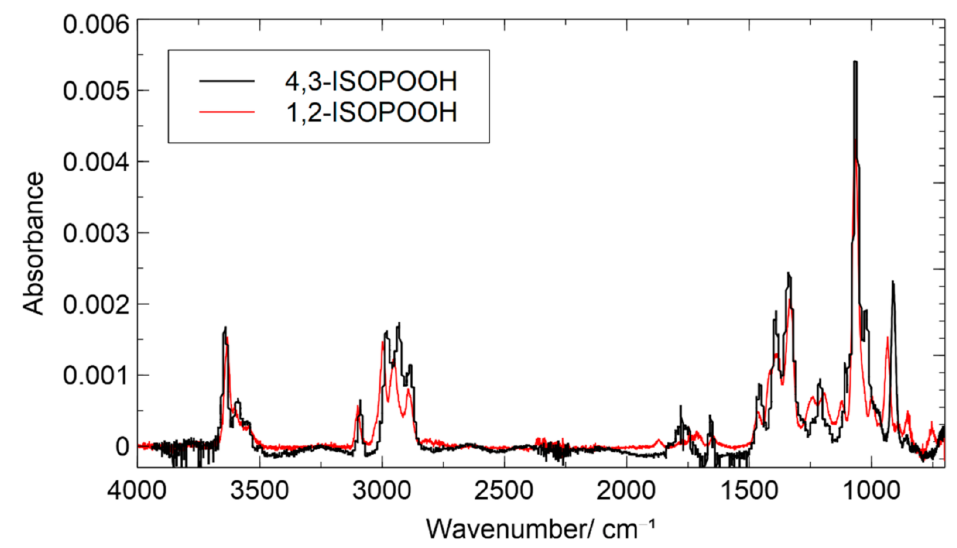
Figure 6. Gas-phase FTIR spectrum of 4,3-ISOPOOH, combined with the FTIR spectrum of 1,2-ISOPOOH (red